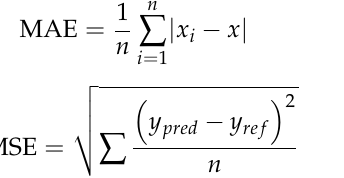
Table 2. Statistical analysis of the approaches used. Models